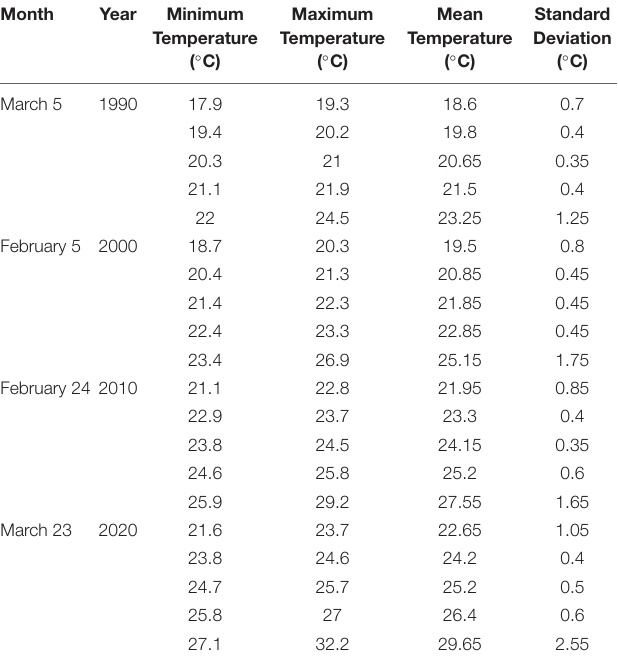
TABLE 2 | Variation of five temperature classes of DDWS in selected time periods.